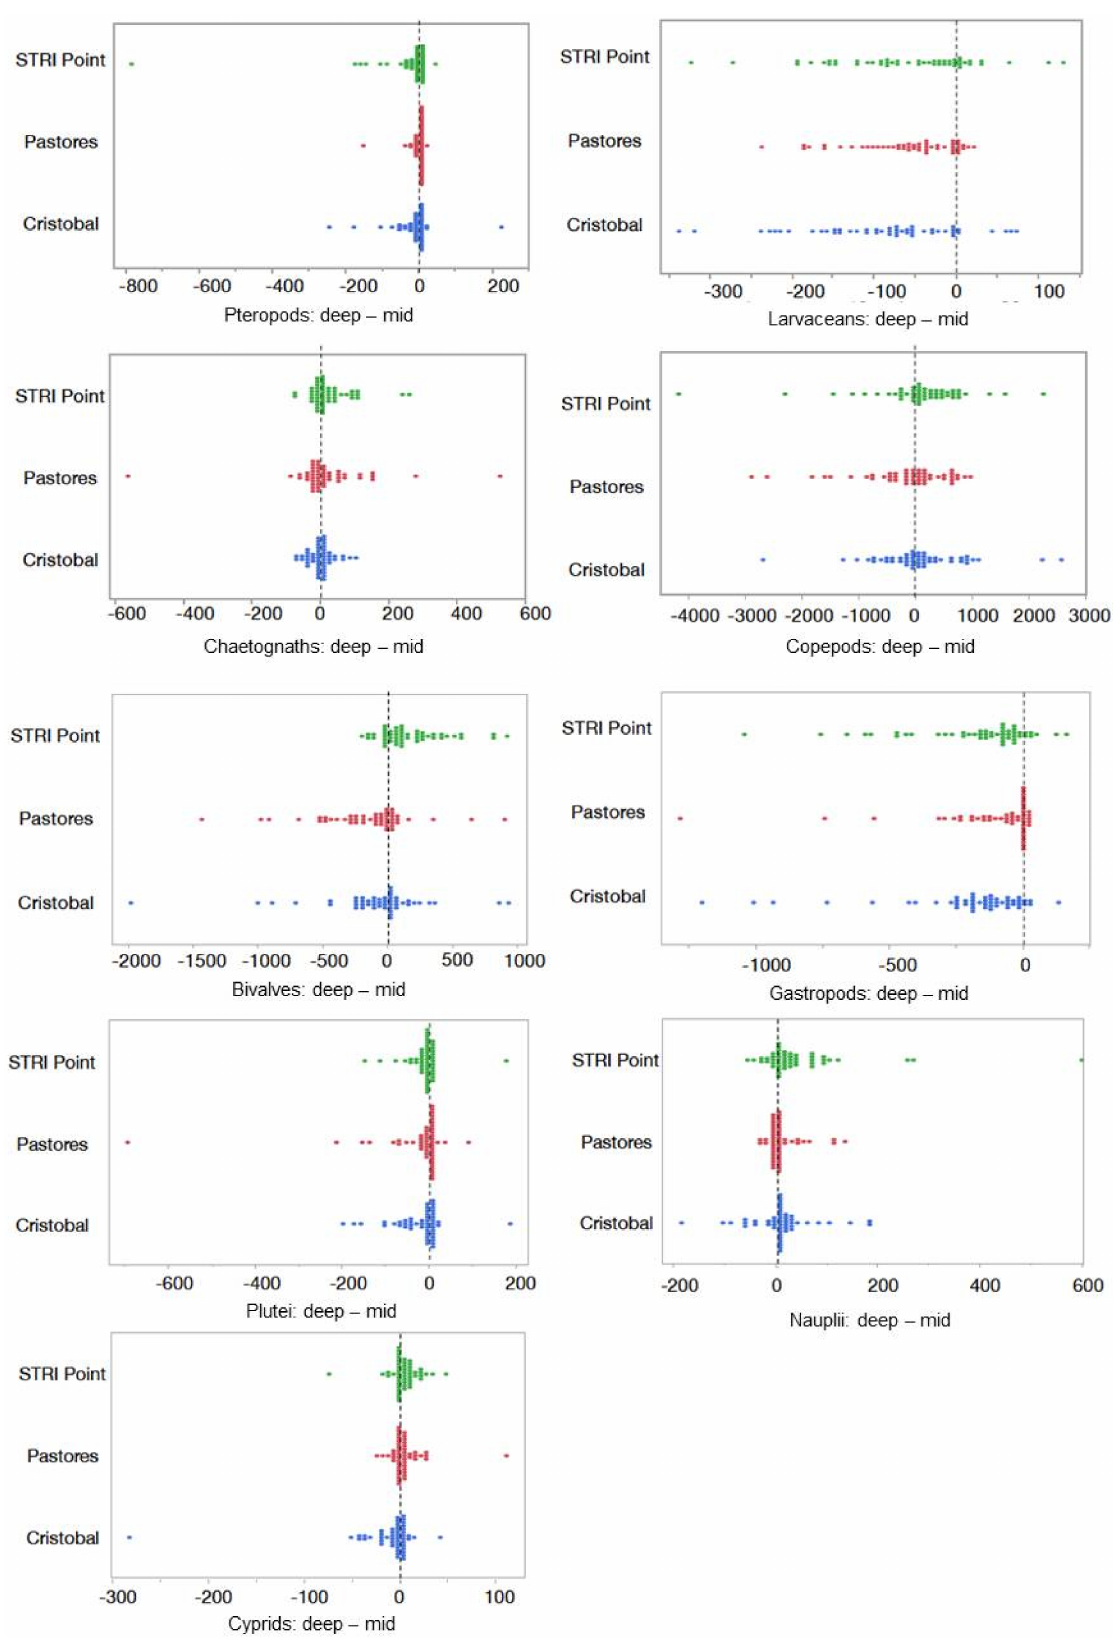
Figure 8. Differences between abundances in deep and mid samples. Points to the left of 0 have higher abundance in mid waters, while points to right of 0 have greater abundances in deep